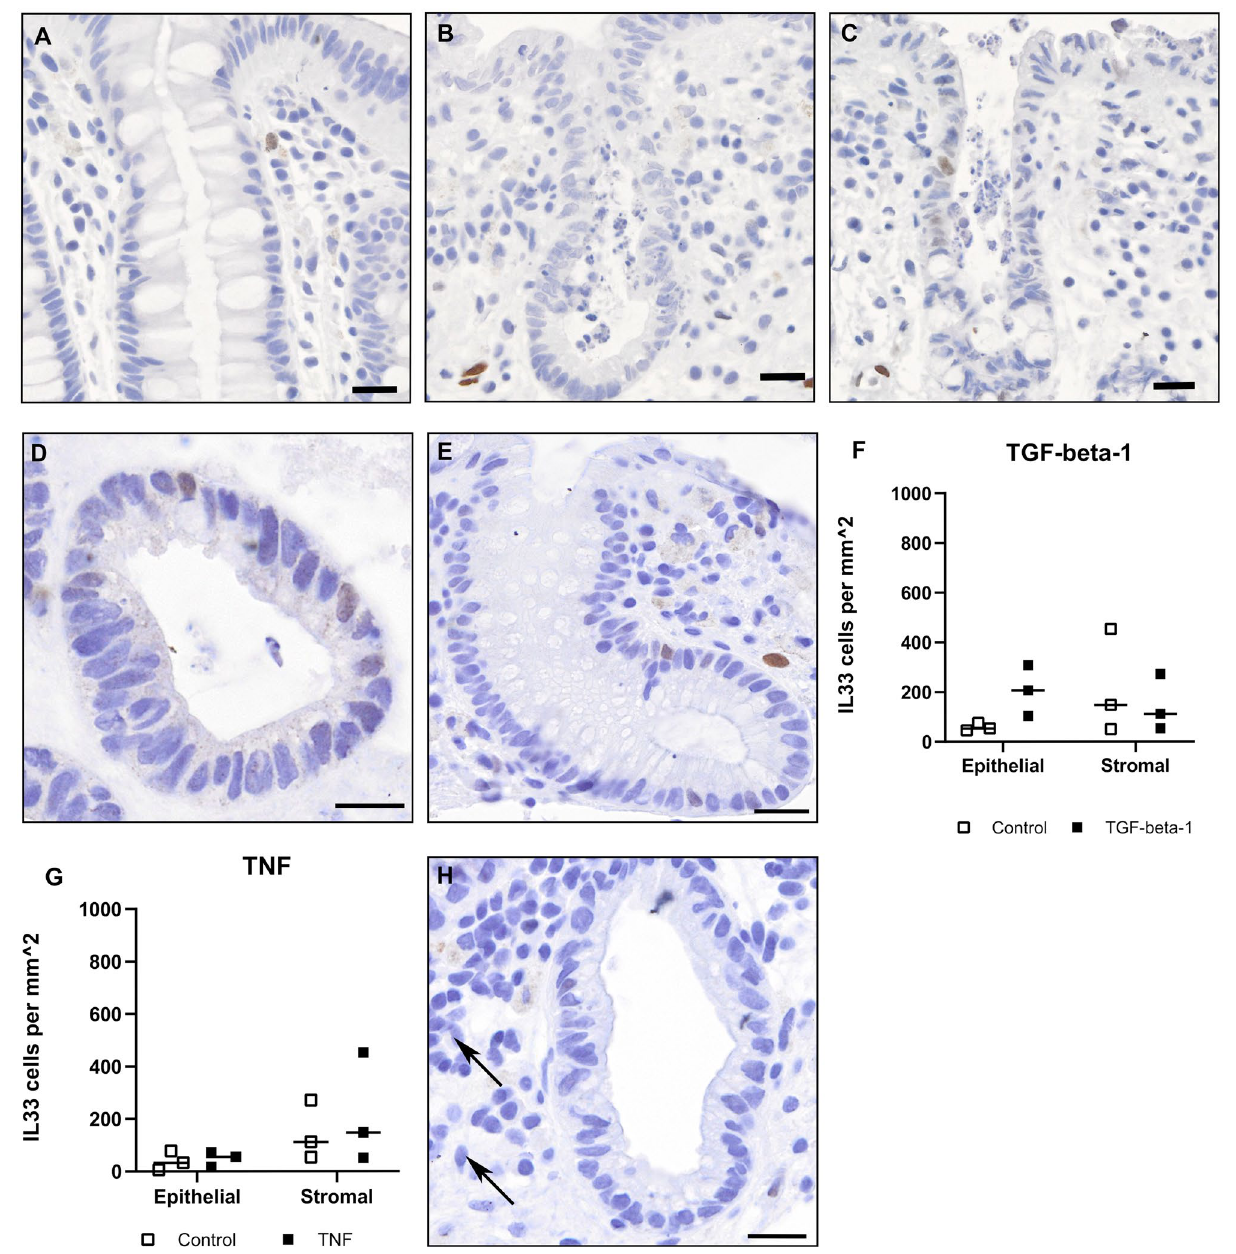
Figure 5. Ex vivo biopsies stained for IL-33 . Colonic biopsies from healthy controls showing immunoenzymatic staining for IL-33 (brown) and cell nuclei counterstained with hematoxylin (blue). ( A – C) shows biopsies at: baseline 0 hours ( A ) 12 h ( B ) and 24 h ( C ) with stimulation with TGF-beta-1 10 ng/ml. Sporadic but positive epithelial cells for IL-33 were seen. Images ( D,E ) also show healthy controls after 24 h of TGF-beta-1 stimulation. Image ( H ) shows stimulation with proinflammatory cytokine TNF 10 ng/ml for 24 h, with no positive epithelial cells for IL-33, also of note IL-33 in endothelial vessels was lacking (arrows). Scale bars = 20 µm. Graphs ( F ) and ( G ) shown results from image quantification of positive